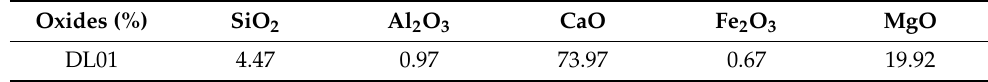
Table 6. Oxide composition of dolomite limestone.